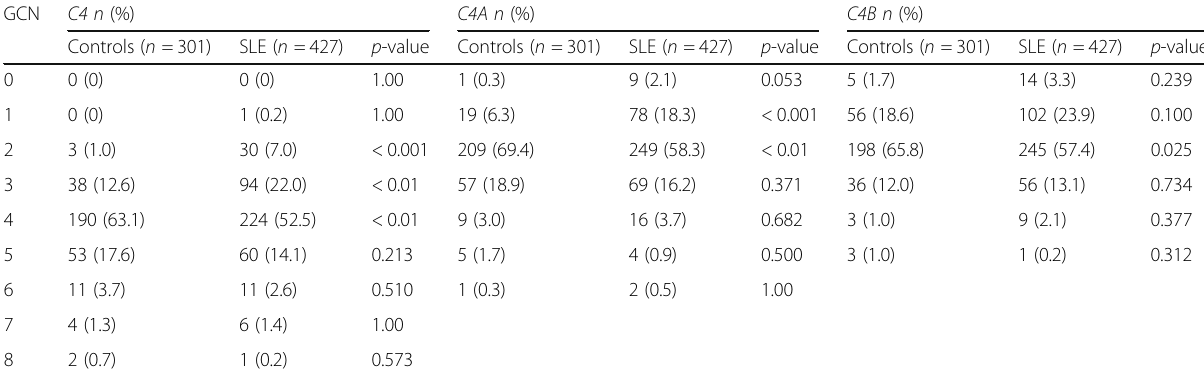
Table 3 Distribution of SLE and controls according to the gene copy number for total C4 , C4A and C4B GCN C4 n (%) C4A n (%)